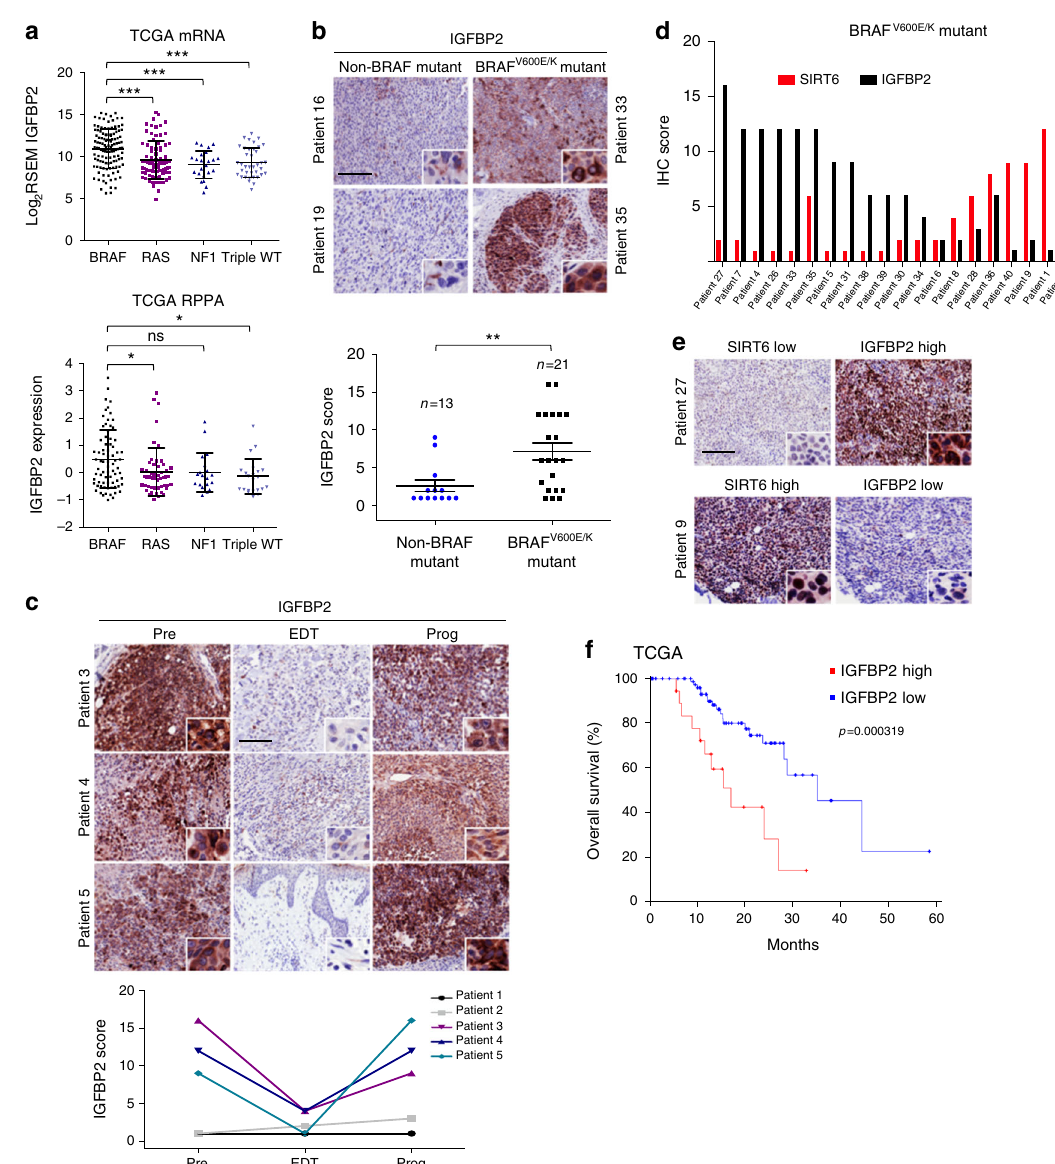
Fig. 5 IGFBP2 represents a potential biomarker for MAPKi resistance in BRAF mutant melanoma. a IGFBP2 mRNA expression from TCGA samples classi fi ed by mutational status (top). IGFBP2 protein expression (RPPA) from TCGA samples classi fi ed by mutational status (bottom). Data are mean ± SD; * P < 0.05, *** P < 0.001; One-way ANOVA was used for comparisons. b IHC (immunohistochemistry) for IGFBP2 in non-BRAF mutant or BRAF V600E/K mutant melanoma tissue (Supplementary Data 5). Images ×10 magni fi cation; insets ×40 magni fi cation. Scale bar represents 100 µ m. Scores obtained by multiplying the percentage of positively stained cells (1 – 4) by intensity of stain (1 – 4). Data are mean ± SEM; ** P < 0.01; Mann – Whitney (two-tailed) was performed for comparison. c IHC for IGFBP2 in matched tumor samples (Patients 3, 4, and 5; Supplementary Data 5) taken before treatment (Pre), early during treatment (EDT), and on disease progression (Prog). Images ×10 magni fi cation; insets ×40 magni fi cation. Scale bar represents 100 µ m. Scores obtained as in b . d IHC scores of SIRT6 and IGFBP2 in 21 BRAF V600E/K melanoma tissues (Supplementary Data 5); Scores obtained as in b ; Spearman ’ s r = − 0.462; P = 0.035. e Representative IHC for SIRT6 and IGFBP2 in BRAF V600E/K melanoma tissues. Images ×10 magni fi cation; insets ×40 magni fi cation. Scale bar represents 100 µ m. Scores obtained as in b . f Overall survival strati fi ed by IGFBP2 protein expression (RPPA) from TCGA samples (primary tumors, n = 92). High IGFBP2 protein level in red; z -score threshold > 0.5 or low IGFBP2 protein level in blue; z -score threshold < 0.5. P -values, log rank